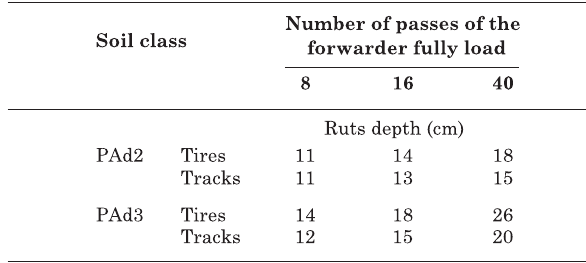
Table 2. Rut depth after the traffic of the